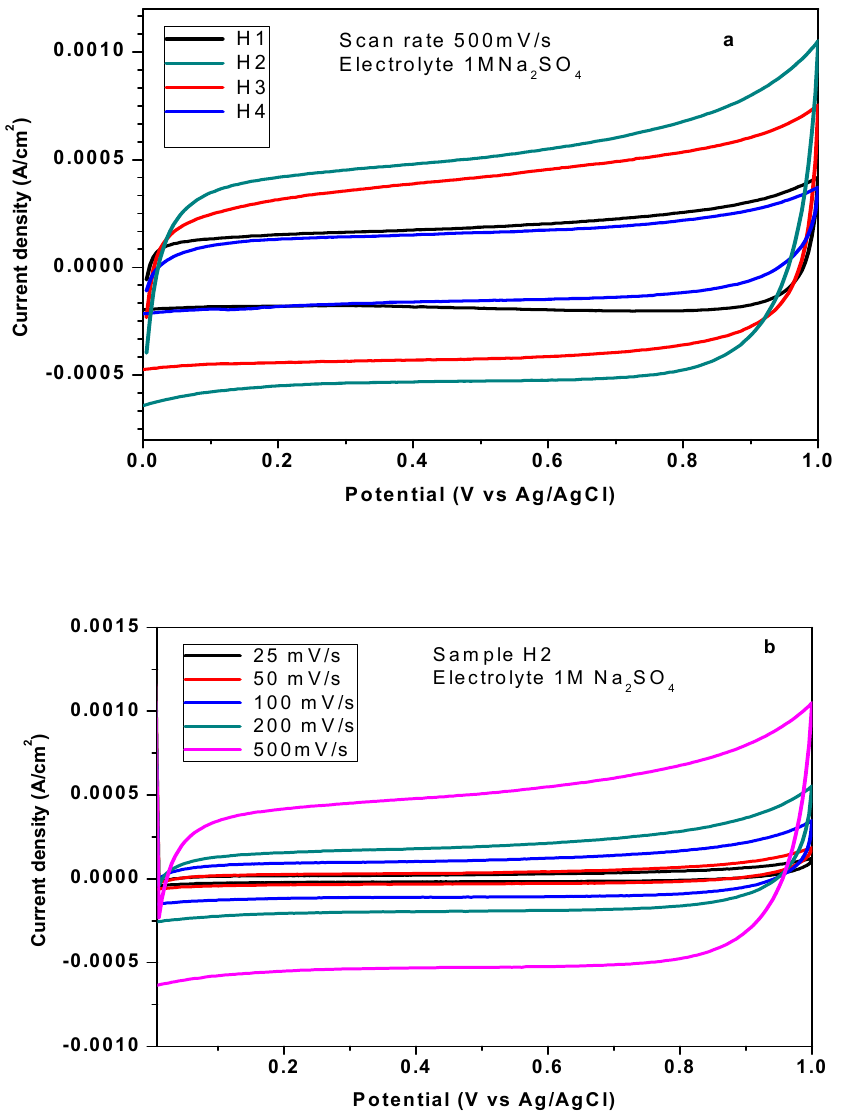
Figure 13. ( a ) Comparative cyclic voltammetry (CV) profiles of samples H1–H4 at 500 mV / s, ( b ) CV profiles of sample H2 at di ff erent scan